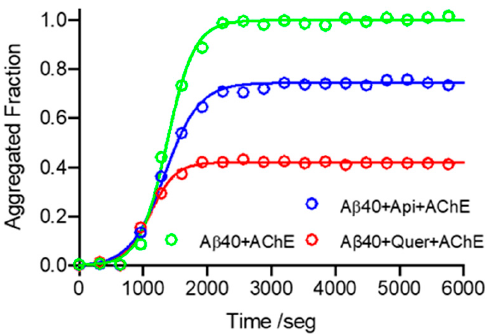
Figure 5. Time-course kinetics of AChE-induced A β 40 aggregation in the absence and presence of the two flavonoids quercetin and apigenin, followed by ThT fluorescence. Green: without flavonoid; blue: with apigenin; red: with quercetin. Conditions: [Quercetin/Apigenin] = 20 μ M; [A β 40] = 20 μ M